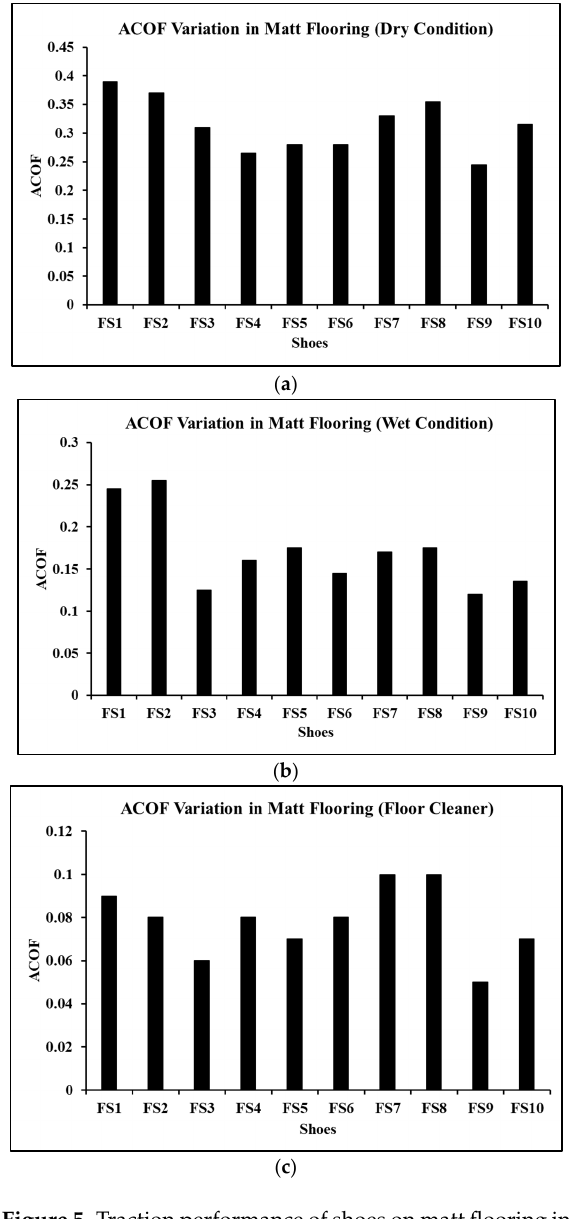
Figure 5. Traction performance of shoes on matt flooring in: ( a ) dry condition, ( b ) water ‐ contaminated condition, and ( c ) floor ‐ cleaner ‐ contaminated condition.